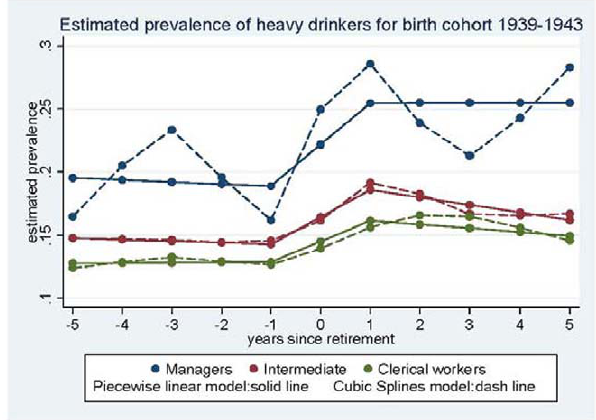
Figure 3. Estimated prevalence of heavy drinkers - Women.